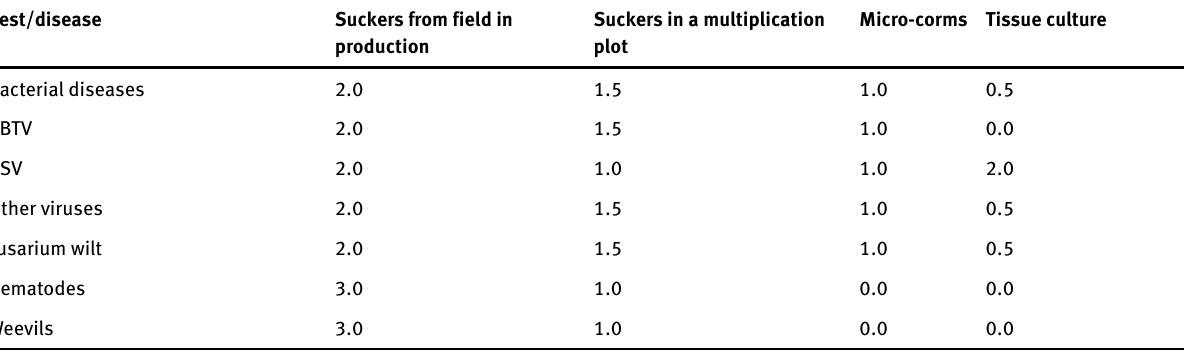
Table 1: Relationship between risk of pest and/or disease transmission and banana propagation method (Karamura and Staver 2010)